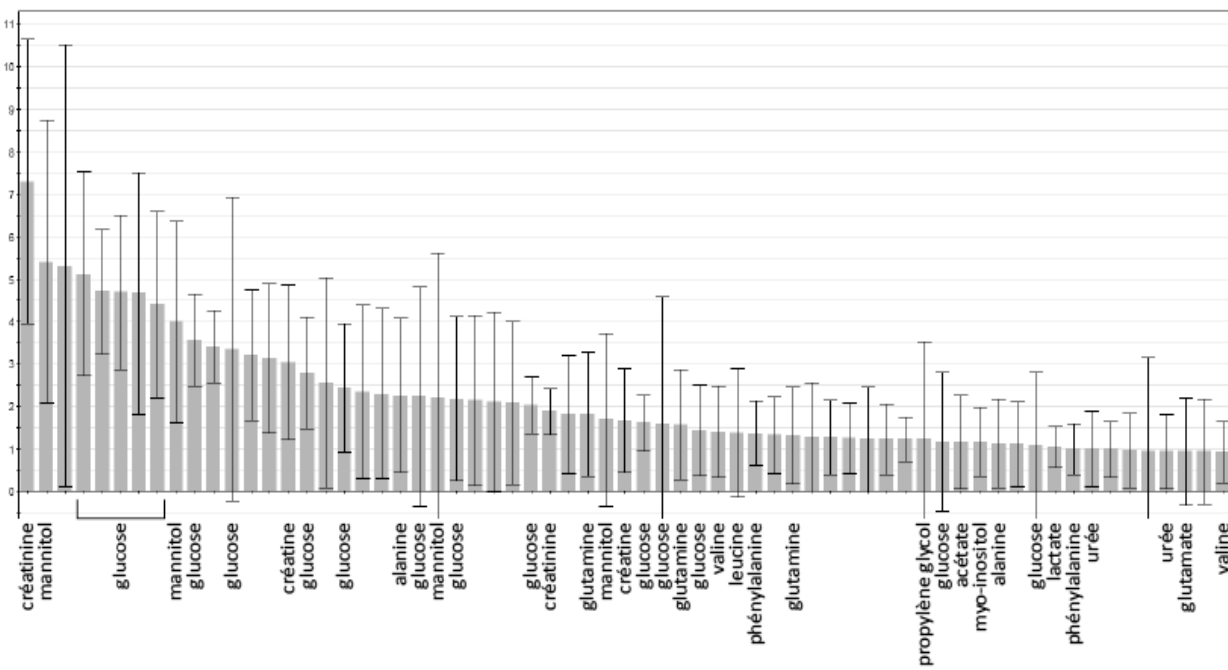
Table 5. Comparisons of the area under the curve (AUC) values for several metabolic products in the four patient groups.